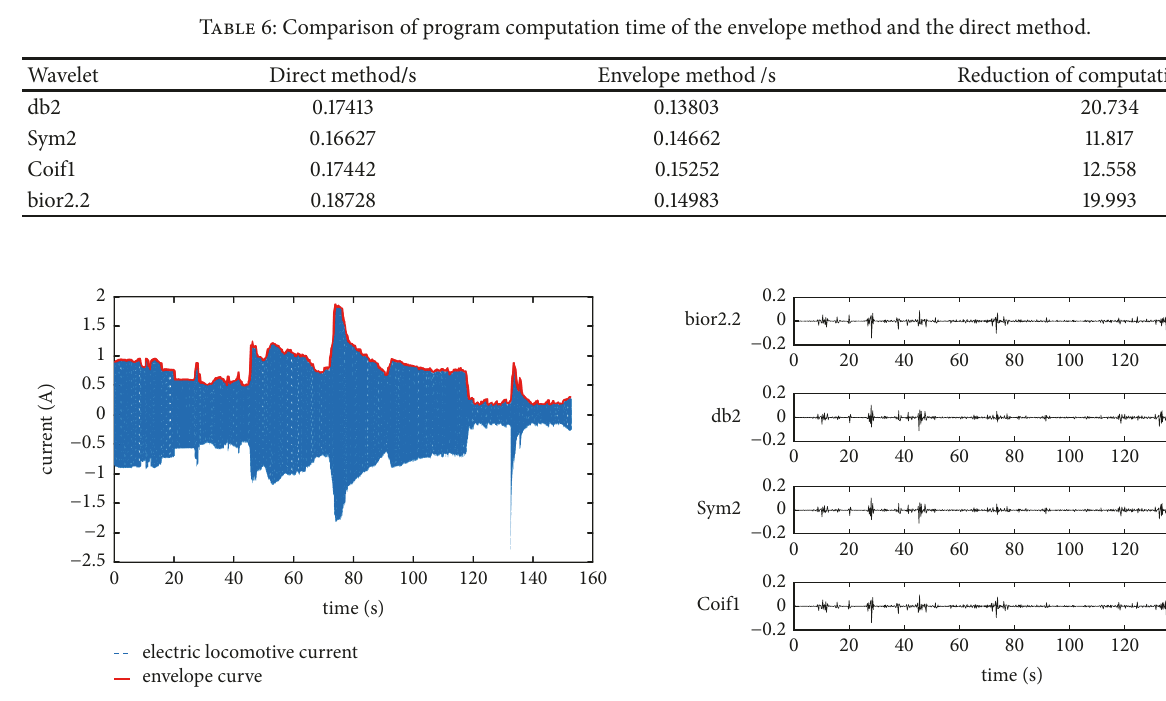
Figure 7: Electric locomotive current waveform and its upper envelope.